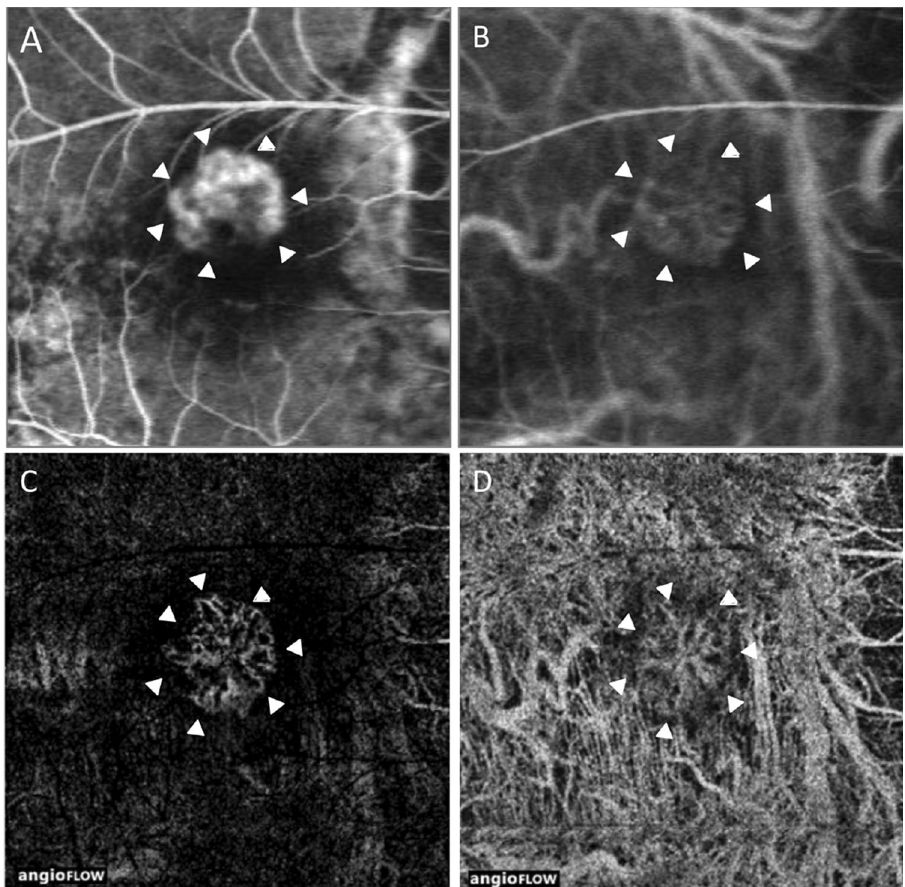
Figure 1. Fluorescein (FA) and indocyanine green angiography (IA) and optical coherence tomography angiography (OCTA) images of choroidal neovascularization (CNV) owing to pathologic myopia of the right eye in a 68-year-old man without anti-vascular endothelial growth factor treatment. Arrowheads ( A ‒ D ) indicate the location of CNV. ( A ) An early-phase FA image (34 s) shows hyperfluorescence corresponding to CNV. ( B ) An early-phase IA image (44 s) shows faint hyperfluorescence from CNV, which coincides with CNV in the FA image. ( C ) The outer retinal layer on the OCTA image of the identical retinal field on FA and IA images shows a flow signal. The location is similar to that observed with FA, and the vascular pattern is similar to that observed with IA. ( D ) An OCTA image of the choriocapillaris layer shows a vascular complex at the same location as in the outer retinal layer on an OCTA image. The choriocapillaris flow deficit around CNV is also detected as a dark area around CNV.